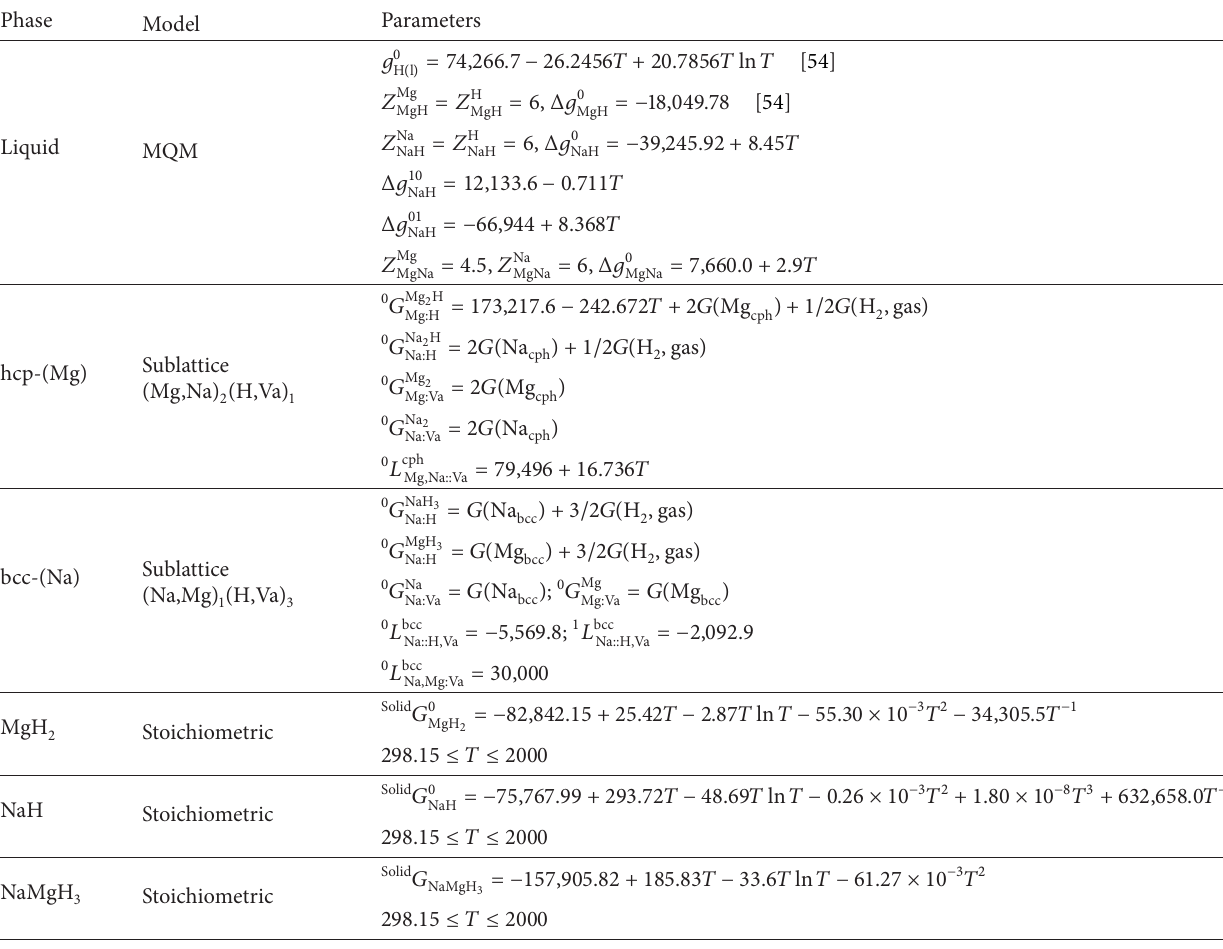
Table 1: Optimized model parameters for the different phases in the H-Mg-Na system